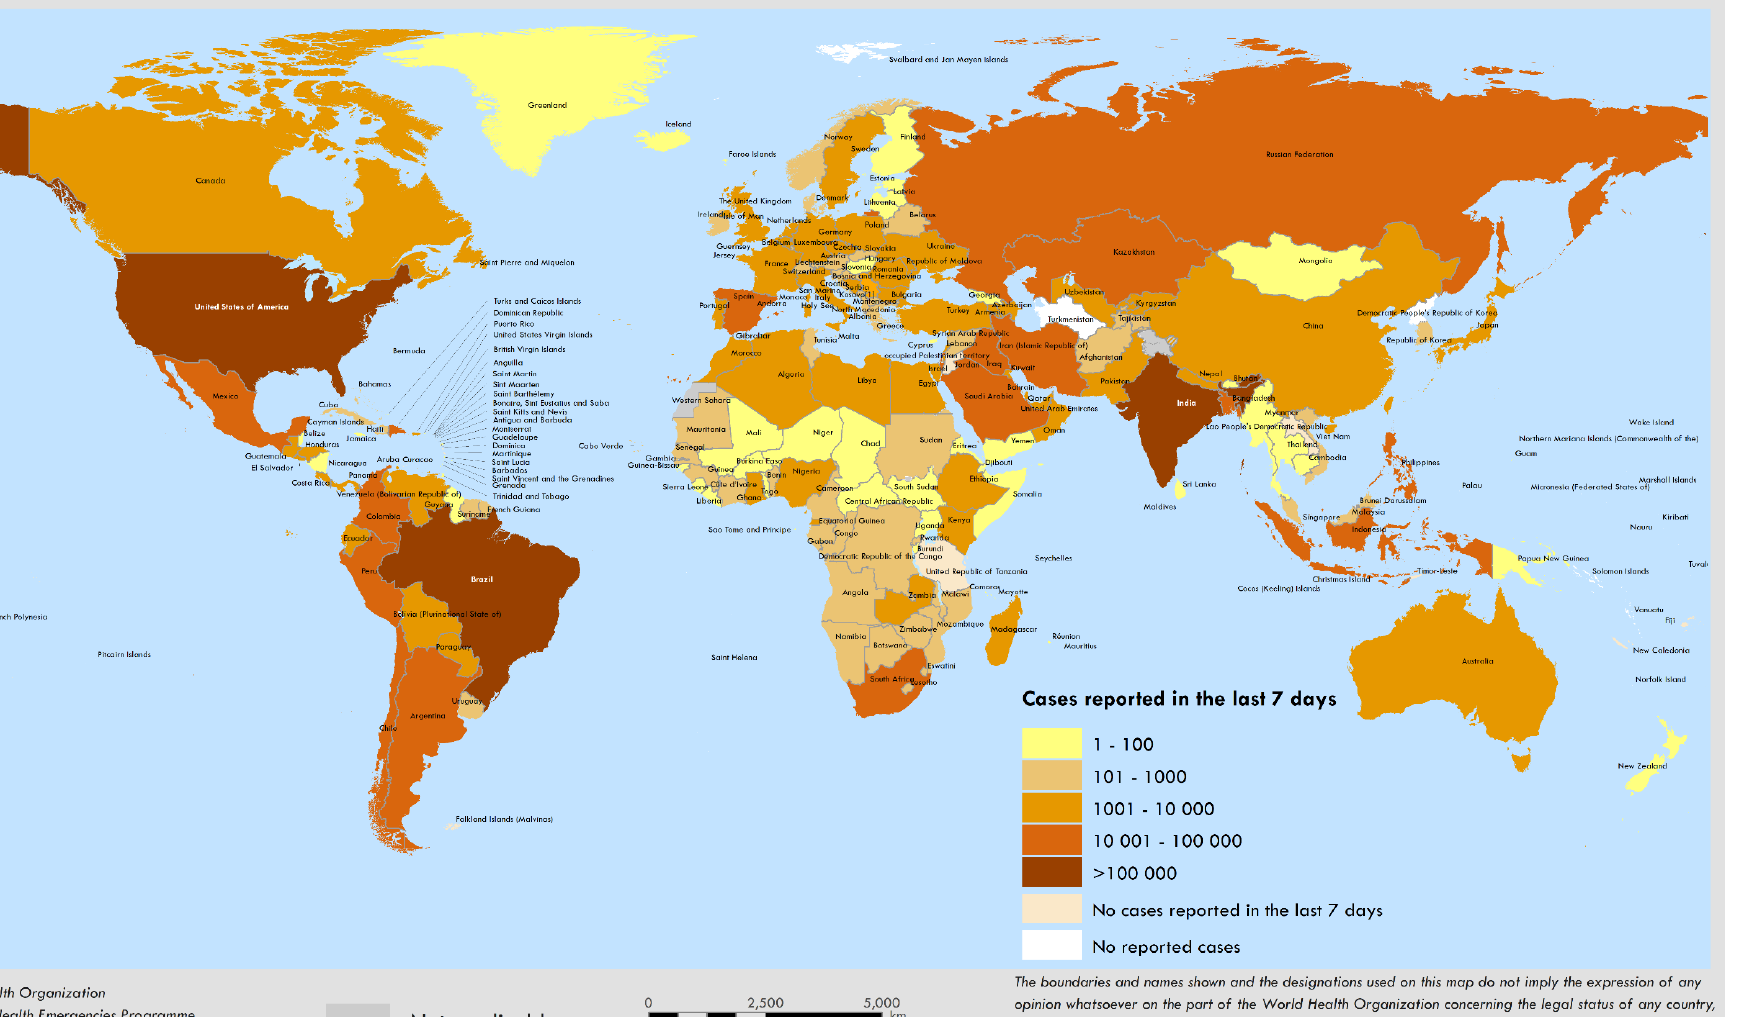
Figure 1. Number of confirmed * COVID-19 cases reported in the last seven days by country, territory or area, 26 July to 1 August **